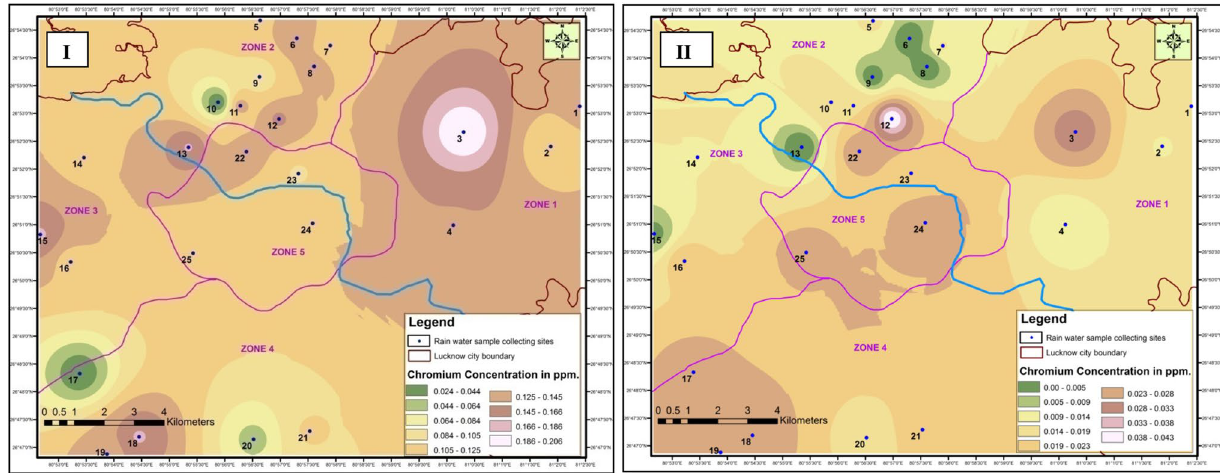
Fig. 7 Contour Map of chromium values at five zones of Lucknow city during first (I) and second (II)